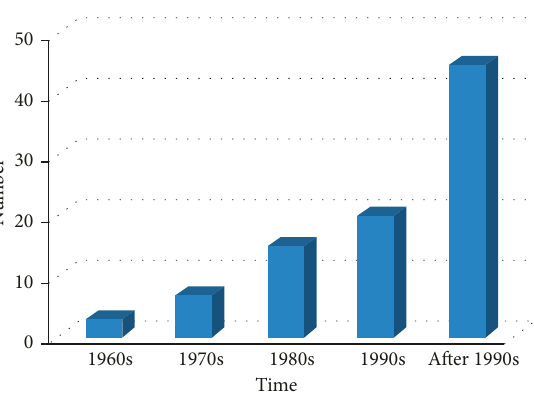
Figure 2: The development trend of shaking table in China.